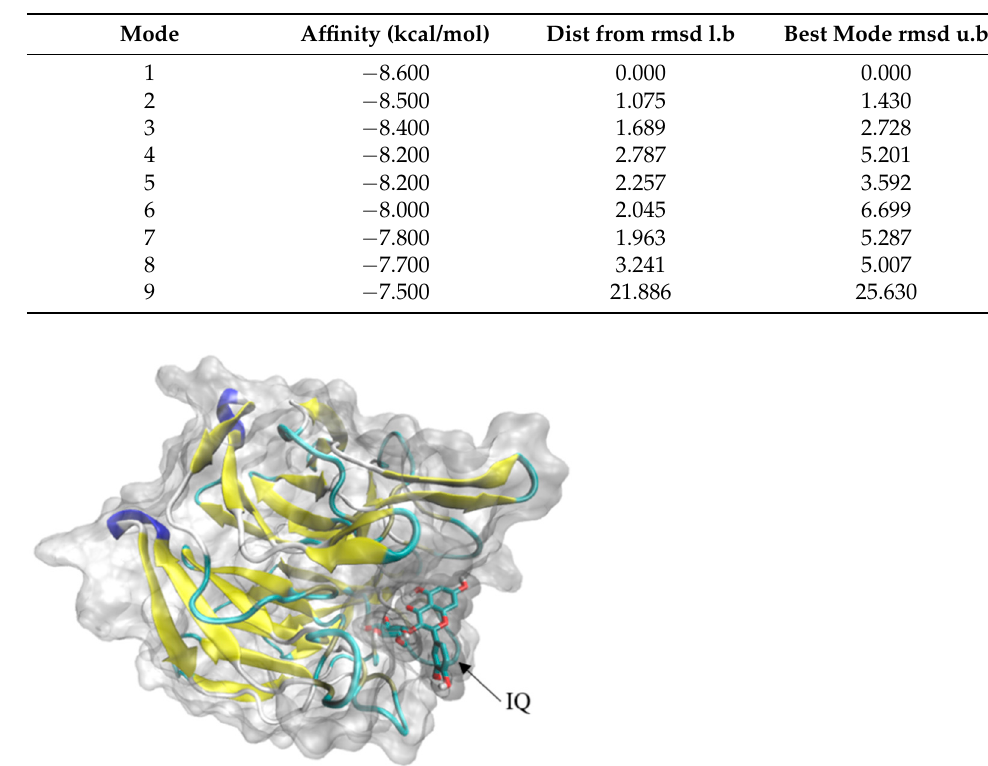
Table 1. Binding energy of IQ and Keap1.